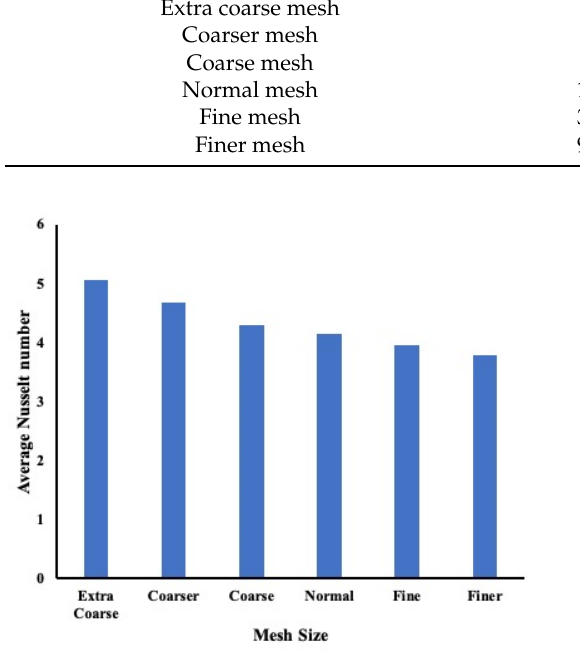
Figure 3. Mesh sensitivity analysis